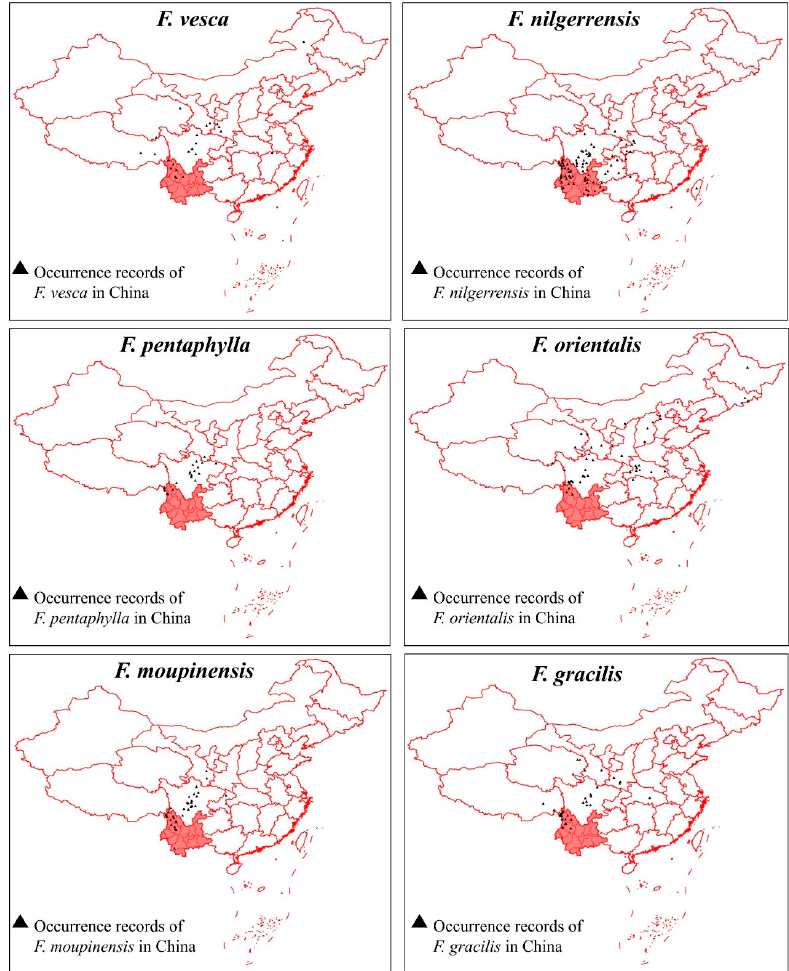
Figure 1. Distribution localities of six wild strawberry species in China ( F. vesca , F. nilgerrensis , F. pentaphylla , F. orientalis , F. moupinensis, and F. gracilis , respectively). The dates of databases from 1900 to 2020, the collection information for each strawberry species is shown in Table S1.